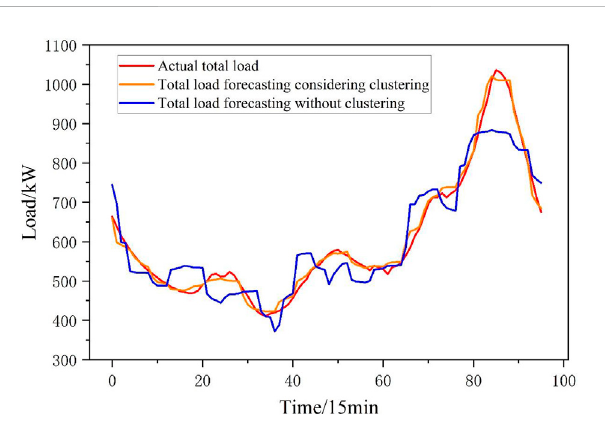
FIGURE 13 Forecasting result of Category 4.